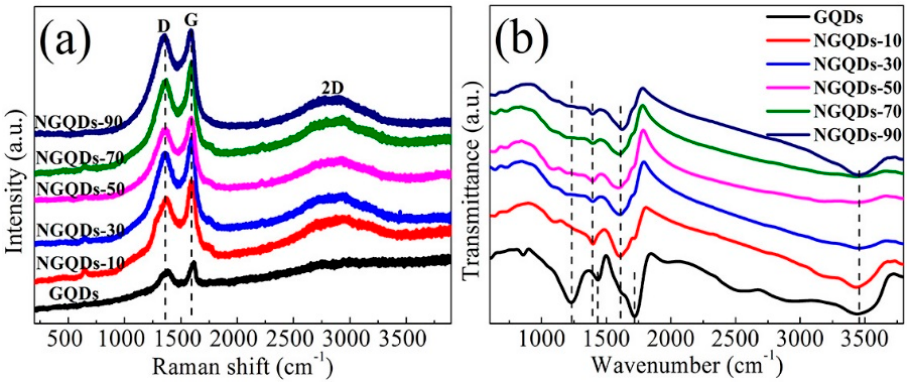
Figure 2. ( a ) Raman spectra; and ( b ) Fourier transform infrared spectroscopy (FT-IR) spectra of the GQD and NGQD samples.